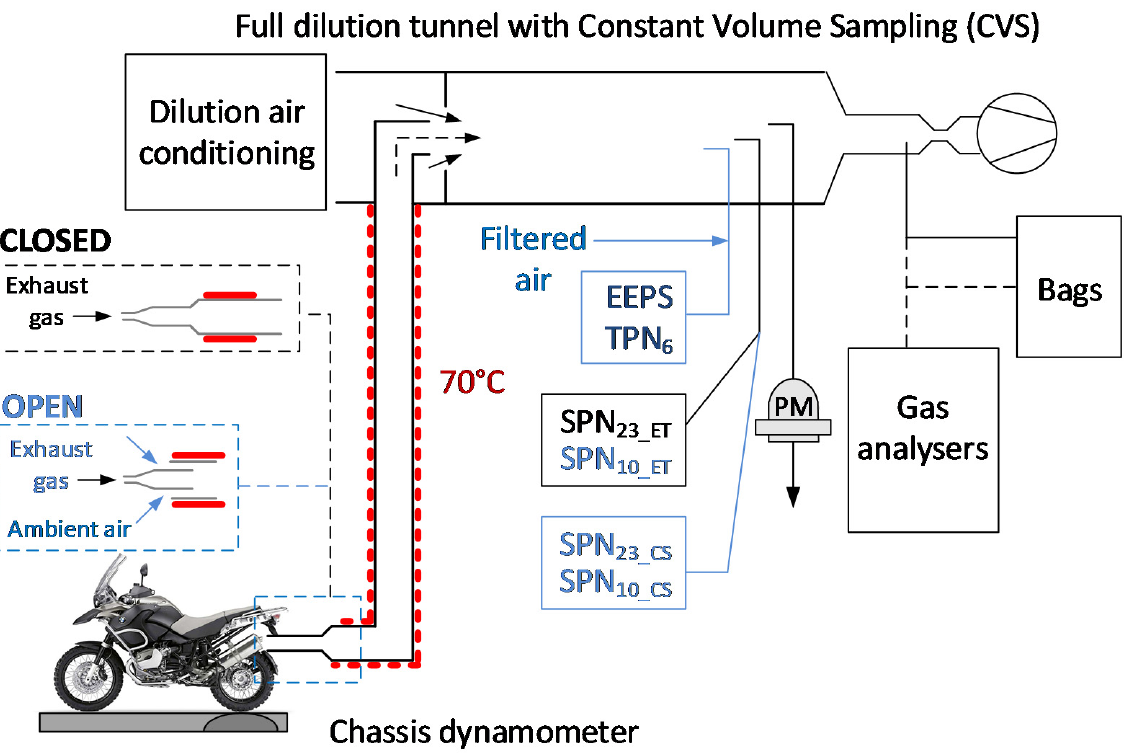
Figure 1. Experimental setup. The two configurations with open and closed transfer tube to the full dilution tunnel are shown in dashed lines. In blue are equipment used only at JRC 2020 campaign. CVS = Constant Volume Sampling; CS = catalytic stripper; EEPS = engine exhaust particle sizer; ET = evaporation tube; PM = particulate matter; SPN = solid particle number; TPN = total particle number. Table 4. Overview of measurement instrumentation.